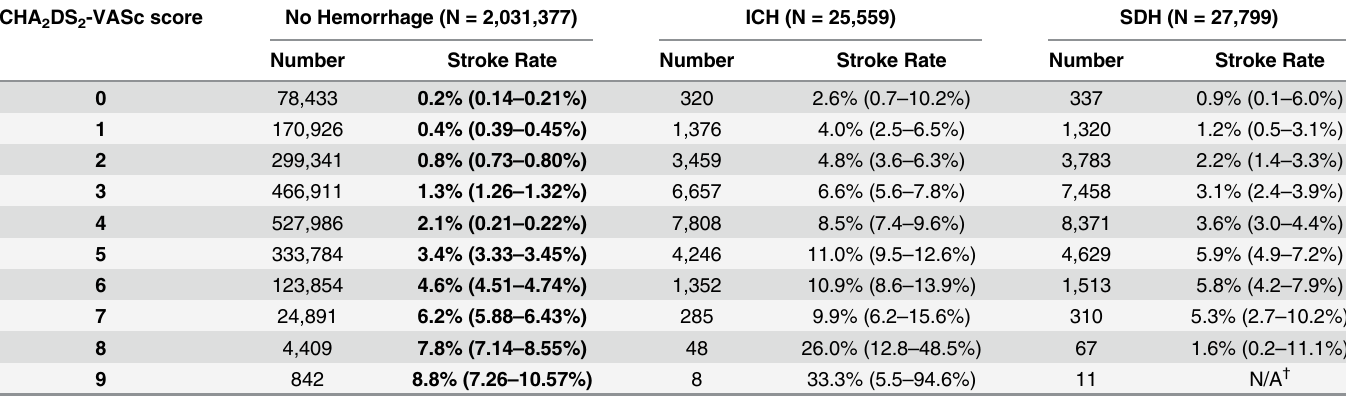
Table 2. Cumulative 1-Year Rates of Ischemic Stroke after Intracranial Hemorrhage in Patients with Atrial Fibrillation, Stratified by CHA 2 DS 2 -VASc Scores *